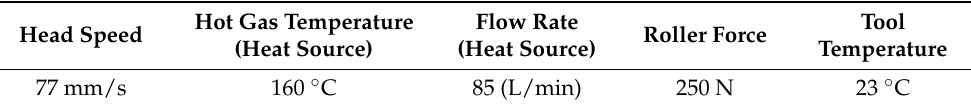
Figure 2. The tow’s path made by AFP machine’s software.